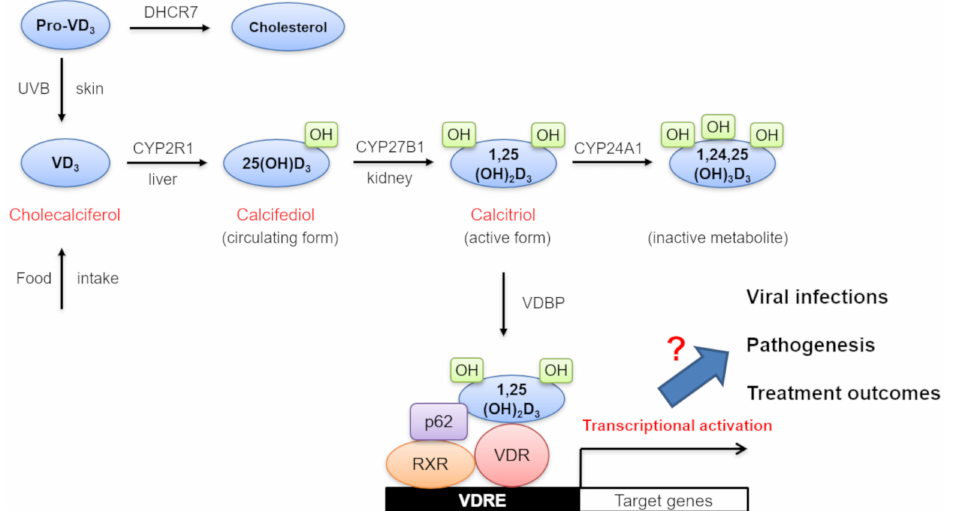
Figure 1. Diagram of vitamin D (VD) synthesis, metabolism, biological action, and its potential e ff ects on viral infections, pathogenesis, and treatment outcomes. Abbreviations: VD 3 , vitamin D 3 ; DHCR7, 7-dehydrocholesterol reductase (DHCR7); UVB, ultraviolet B; 25(OH)D 3 , 25-hydroxy vitamin D 3 ; 1, 25(OH)D 3 , 1, 25-dihydroxy vitamin D 3 ; RXR, retinoic acid receptor; VDR, vitamin D receptor; VDRE, vitamin D responsive